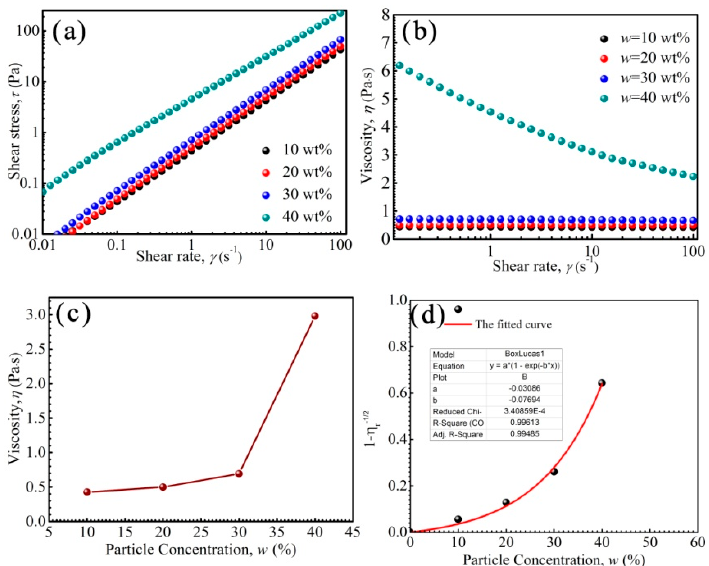
Figure 4. The shear stress of the ferrofluids as a function of shear rate ( a ), the viscosity as a function of shear rate ( b ), the viscosity as a function of nanoparticle concentrations w ( c ) and the 1 − η r − 1/2 as a function of w ( d ).